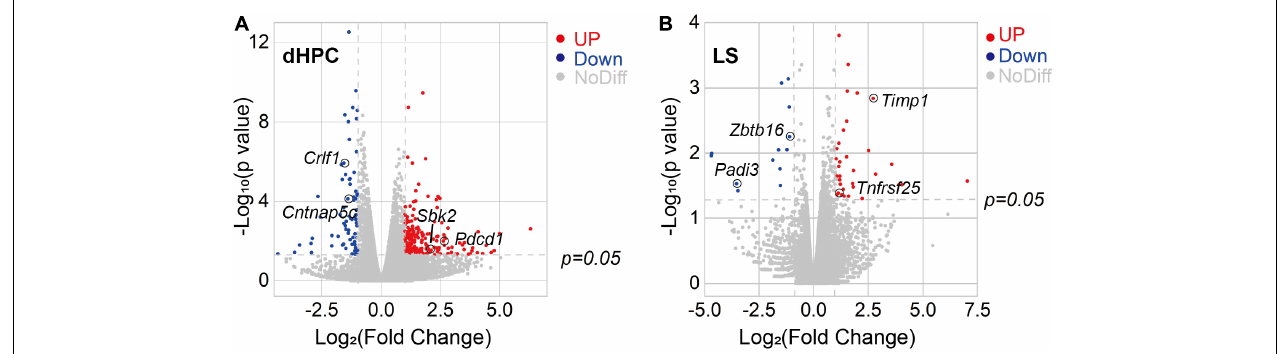
FIGURE 4 | Kainic acid-induced TLE mice showed transcriptome alterations in the hippocampus and lateral septum. (A) Volcano plot of relative RNA expression in DG/CA3 from TLE mice as compared to WT mice. (B) Volcano plot of relative RNA expression in dLS from TLE mice as compared to WT mice [Genes in upper left and right quadrants are significantly differentially expressed. Red dots, up-regulation (dHPC, 65 genes; LS, 34 genes), blue dots, down-regulation (dHPC, 224 genes; LS, 11 genes). WT, n = 4 mice; TLE, n = 6 mice. p < 0.05].